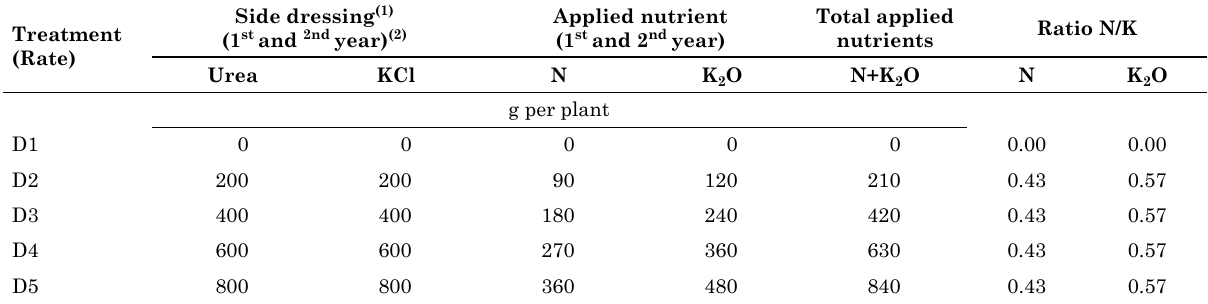
Table 3. Nutrients (N and K) applied in the first two years of development of macaw palm trees grown at the Experimental station of araponga,